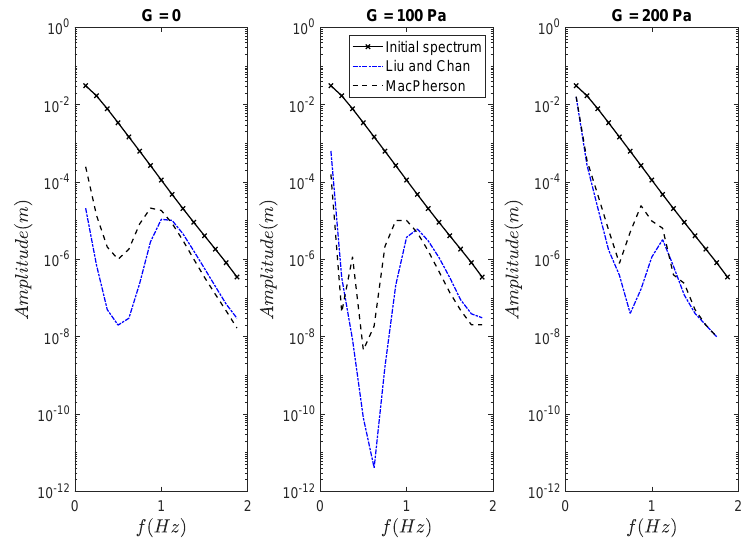
Figure 15. Propagation of cnoidal wave spectrum over mud with shear moduli G = 0,100,200 Pa, h = 0.80 m, d m = 0.40 m, and ρ m = 1111 kg/m 3 .